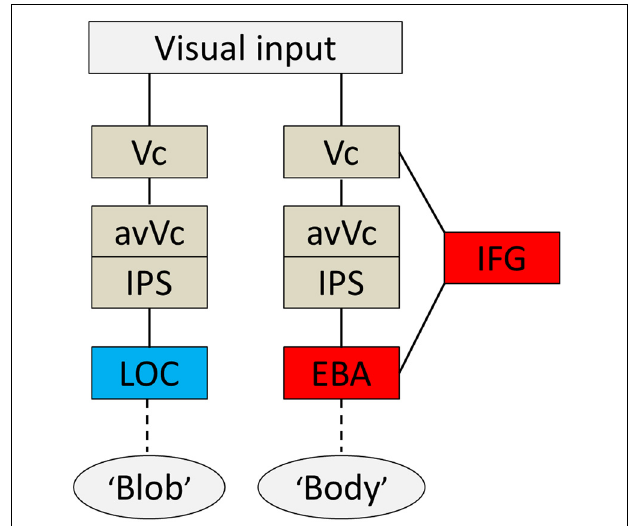
FIGURE 6 | Summary diagram. A proposed hypothetical scheme to illustrate the brain systems involved in disambiguation of ambiguous figures, without implying that the two systems are not linked, either directly or indirectly. The system to the left [early visual cortex (Vc), anterior ventral visual cortex (avVc), intraparietal sulcus (IPS), and lateral occipital complex (LOC)] is engaged in “blob” perception, whereas that to the right [Vc, avVc, IPS, inferior frontal gyrus (IFG), and extrastriate body area (EBA)] is engaged in “body”